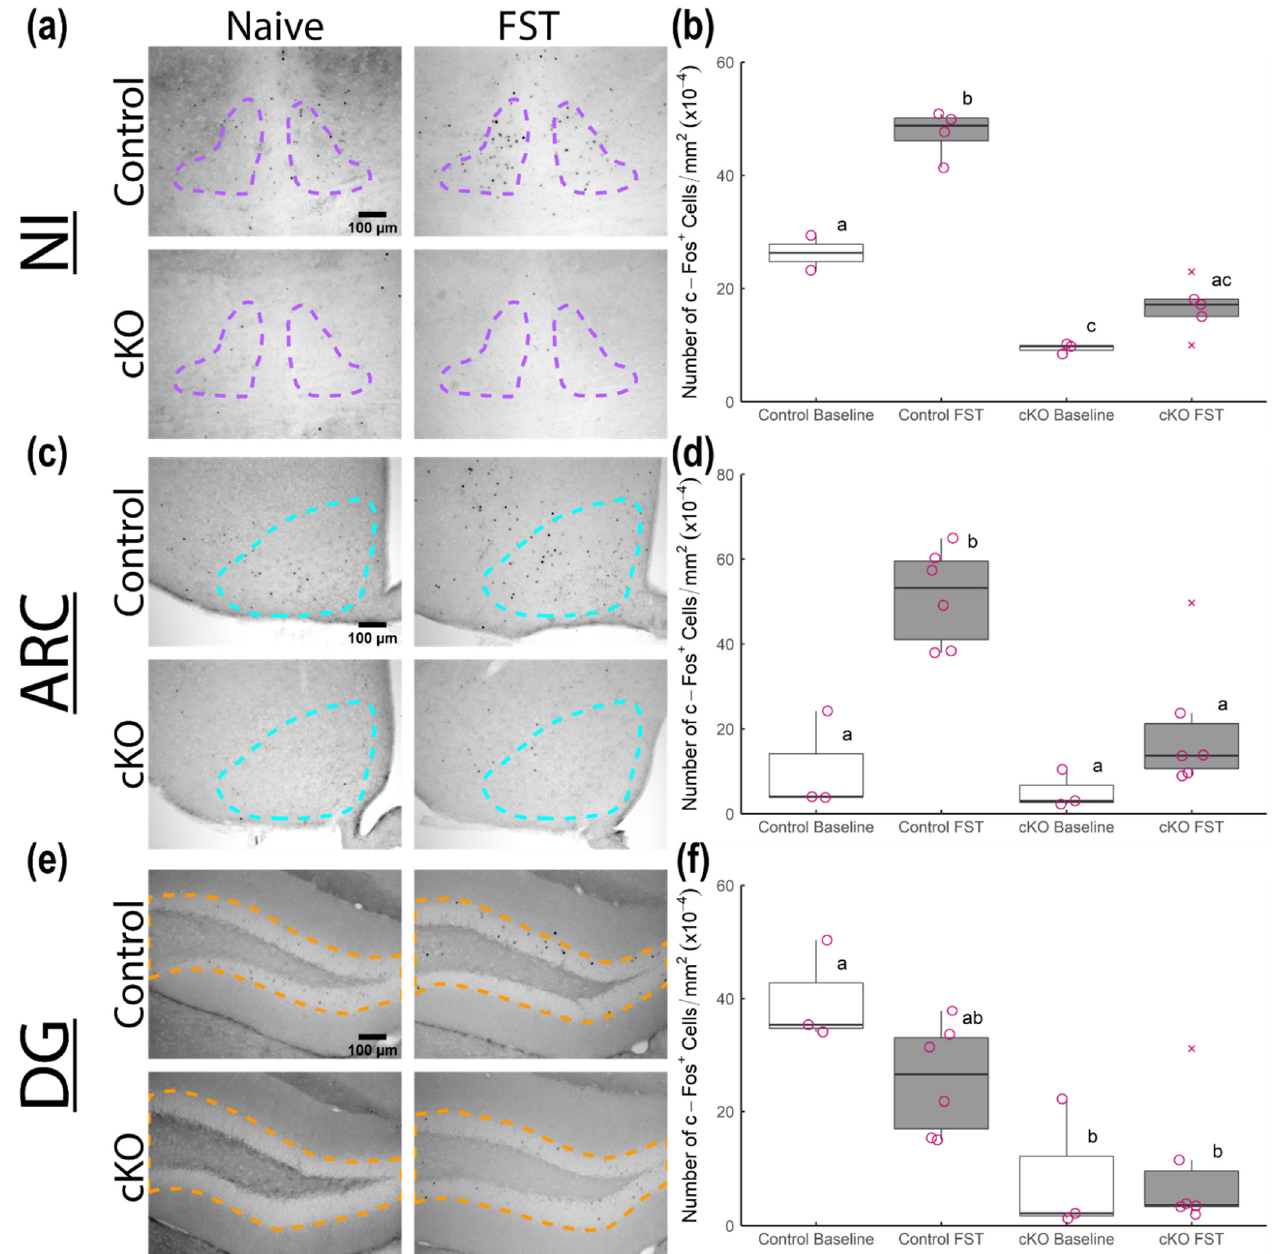
Figure 5. c-Fos induction in various brain regions of Sox2 cKO mice and littermate controls following forced swim. ( a , c , e ) Representative micrographs of anti-c-Fos stained coronal sections with outlines for the nucleus incertus (NI), arcuate hypothalamic nucleus (ARC) and dentate gyrus (DG), respectively. The left-most micrographs are from naïve mice while the right-most micrographs are from mice 90 min after forced swim test (FST). ( b , d , f ) Density of c-Fos-immunoreactive nuclei in each brain region of naïve Sox2 cKO mice ( n = 3), naïve littermate controls ( n = 2 for NI, n = 3 for ARC/DG), FST-stressed Sox2 cKO mice ( n = 5 for NI, n = 6 for ARC/DG), and FST-stressed littermate controls ( n = 4 for NI, n = 6 for ARC/DG). All mice were female, with outliers represented by cross marks. Statistical significance from 2-way ANOVA with Tukey’s post hoc test is represented by letter differences ( p < 0.05).